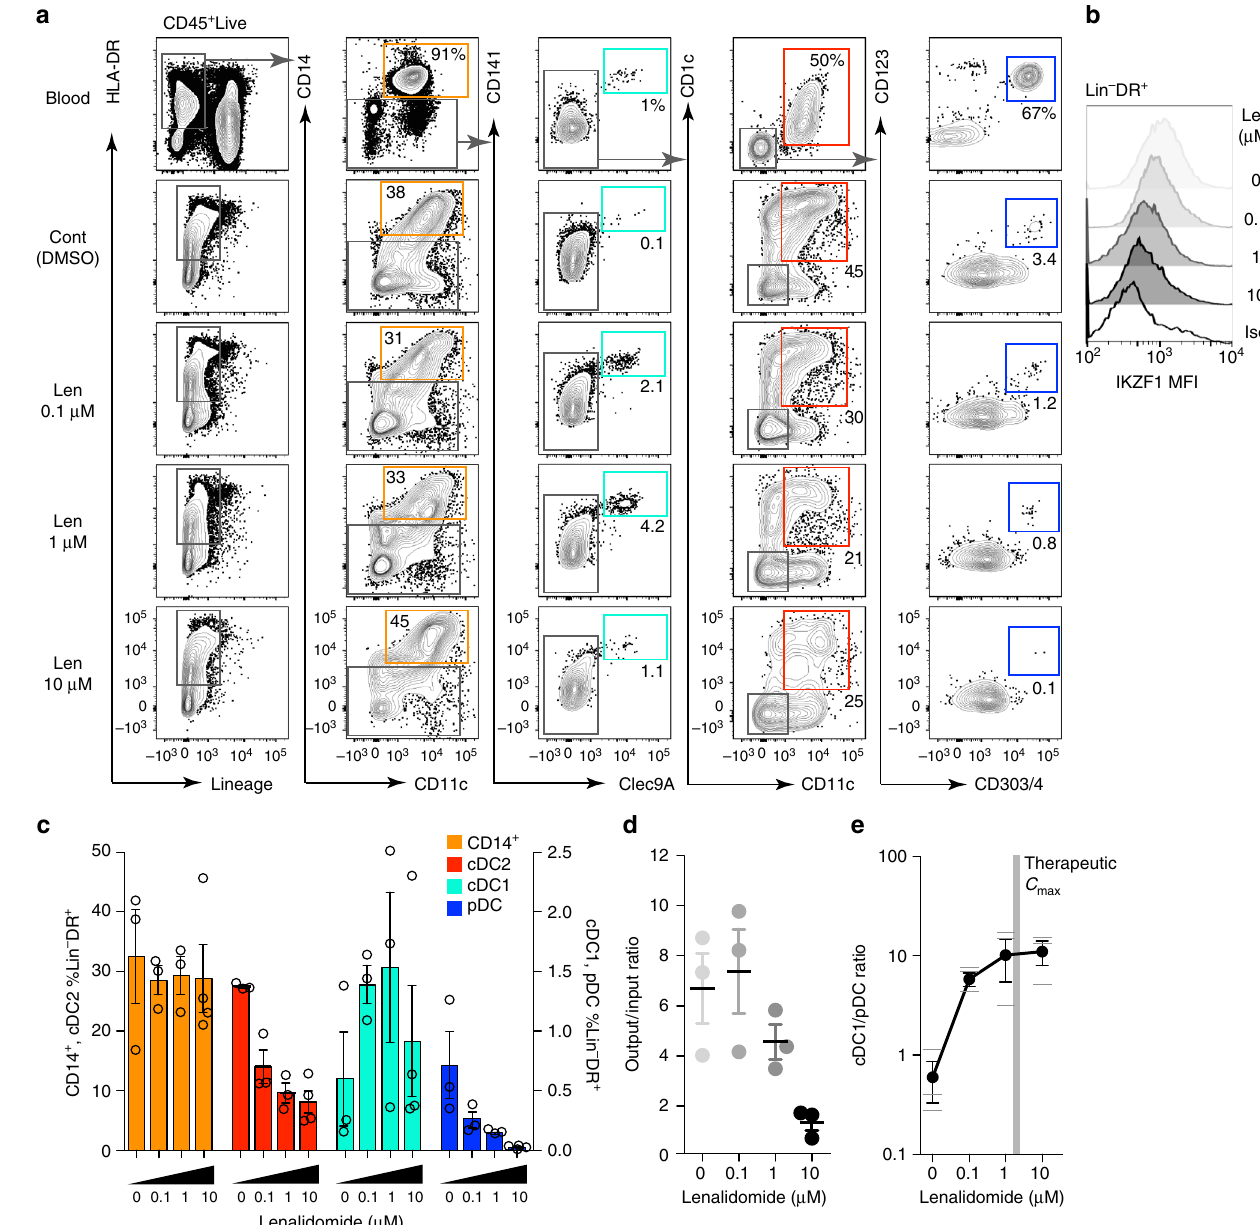
Fig. 5 Impaired in vitro pDC development in IKZF1 de fi ciency. a Phenotypic fl ow cytometric analysis of dendritic cell (DC) subsets generated after 22 days of culture in vitro, compared to PB counterparts. Found within the Lineage − HLA-DR + gate were CD14 + CD11c + monocytes, CD141 + CLEC9A + cDC1s, CD11c + CD1c + cDC2s and CD123 + CD303 + CD304 + pDC. b IKZF1 protein levels, determined by fl ow cytometric analysis and IKZF1 mean fl uorescence intensity (MFI), in Lin − DR + cells after 22 days of culture in the presence of a lenalidomide titration. c Summary of the proportion of in vitro generated Lin − DR + cells identi fi ed as CD14 + monocytes (orange), cDC2 (red), cDC1 (turquoise) and pDC (blue). Bars represent mean and s.e.m. of triplicate wells, dots represent single cultures. d Ratio of total number of Lin − DR + cells generated in vitro per input CD34 + cell in the presence of increasing concentrations of lenalidomide. e Lenalidomide dose response of the cDC1 to pDC ratio of in vitro generated cells. Grey zone indicates published human in vivo plasma C max of lenalidomide (450 – 600 ng/ml or 1.7 – 2.3 μ M). Dots represent mean, bars represent s.e.m. and lines represent individual